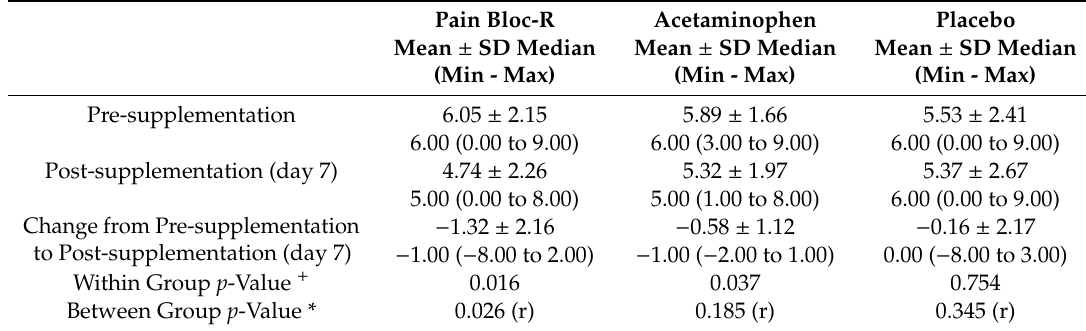
Table 5. The BPI “pain at its worst” score and change in “pain at its worst” score from pre-supplementation to day 7 in the PP population ( n = 19).